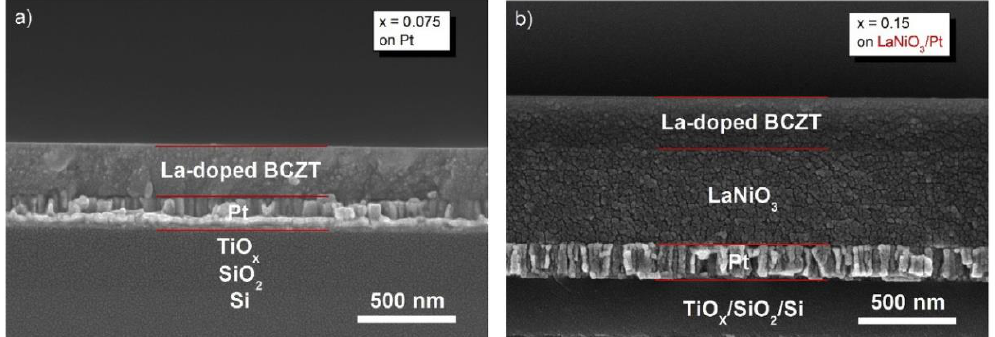
Figure 16. Cross-sectional SEM images of La-doped BCZT thin films at x = 0.0075 and 0.15. ( a ) On Pt bottom electrodes, and ( b ) on LaNiO 3 / Pt composite bottom electrodes. Reprinted with permission from [62]. Copyright 2019 Elsevier.